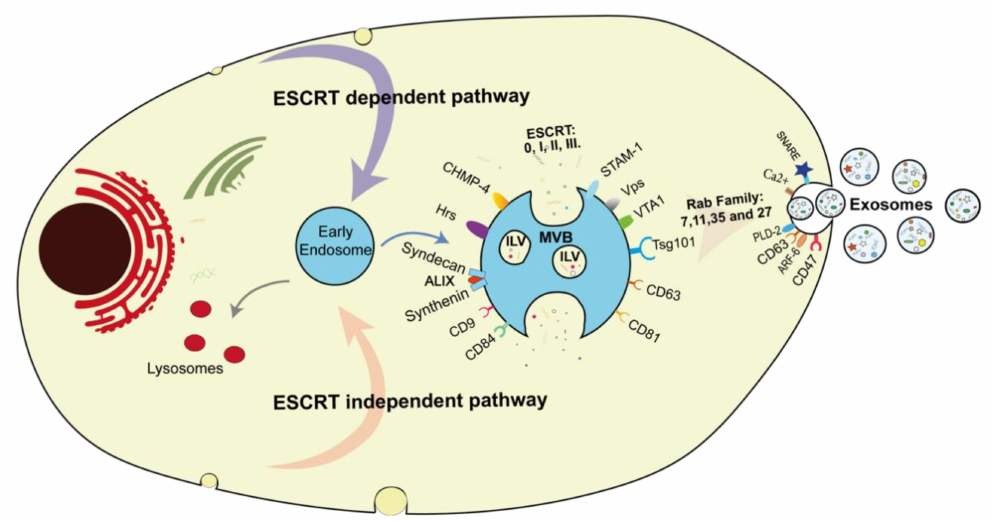
Figure 1. The biogenesis of exosomes, starting from the early endosomes, including both endosomal-sorting complex required for transport pathway (ESCRT). In the ESCRT pathway family (in the upper half of the cell), four sub-proteins 0, I, II, III, and charged multivesicular body protein- 4 (CHMP-4), hepatocyte growth factor-regulated tyrosine kinase substrate (Hrs), Programmed cell death 6-interacting protein (ALIX), signal-transducing adapter molecule 1 (STAM-1), vacuolar protein sorting proteins (Vps), and tumor susceptibility gene 101 ( TSG-101 ) are identified. The ESCRT independent pathway (in the lower half of the cell) includes tetraspanin protein (CD9, CD84, CD81, CD63, CD47) and syndecan-Syntenin-ALIX. Exosome release results from the interaction of the Rab family, including Rab-7, 11, 35, 27 with Tspan and the Soluble N-ethylmaleimide-sensitive-fusion attachment protein receptor